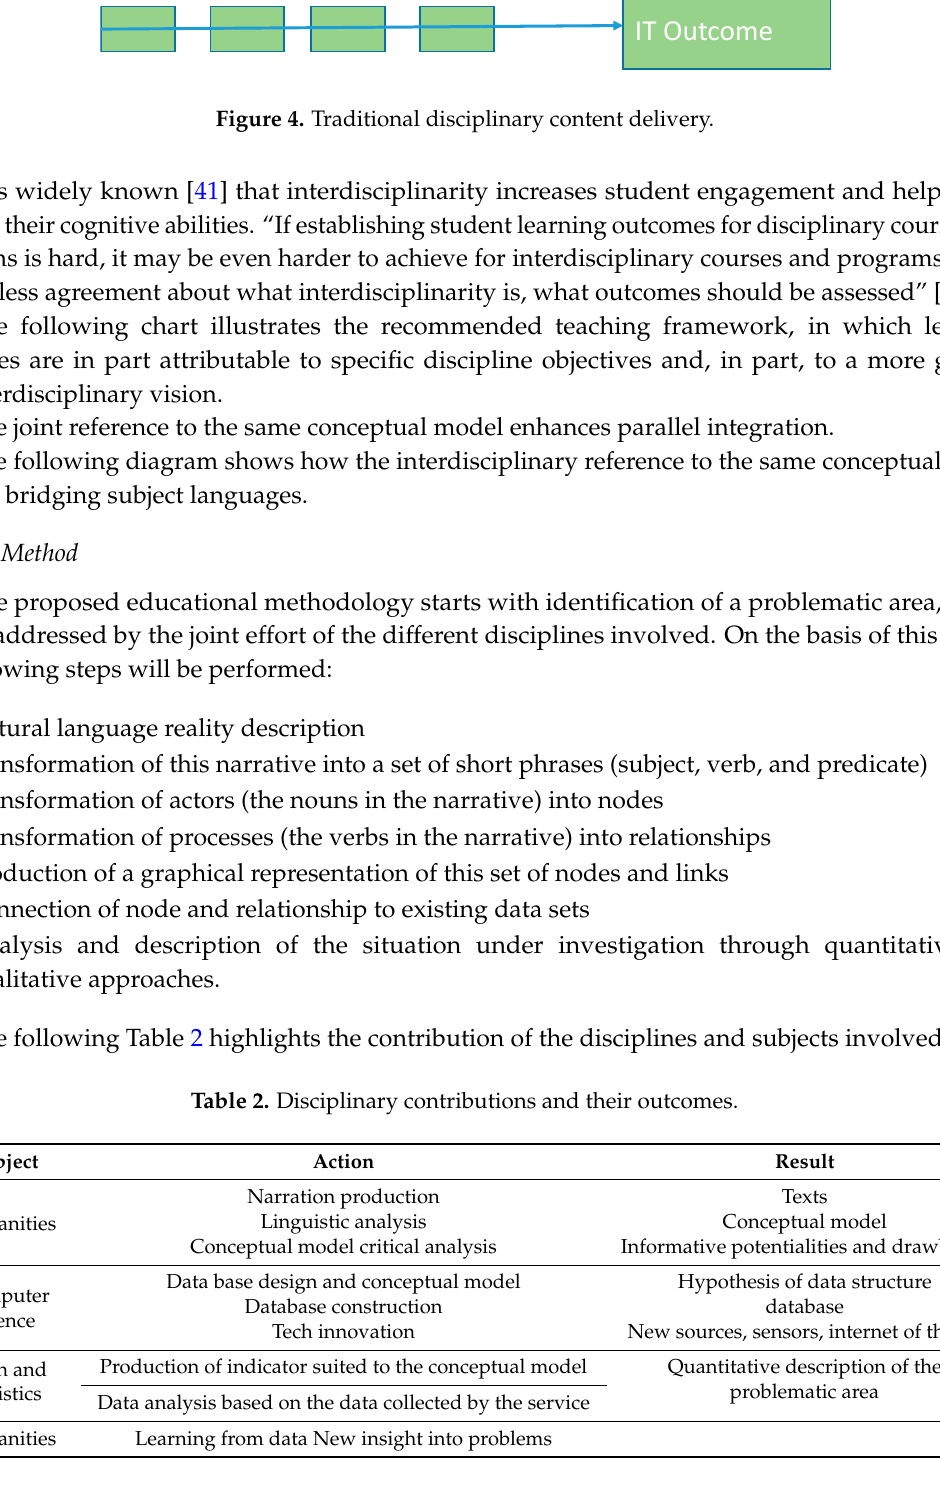
Table 2. Disciplinary contributions and their outcomes.